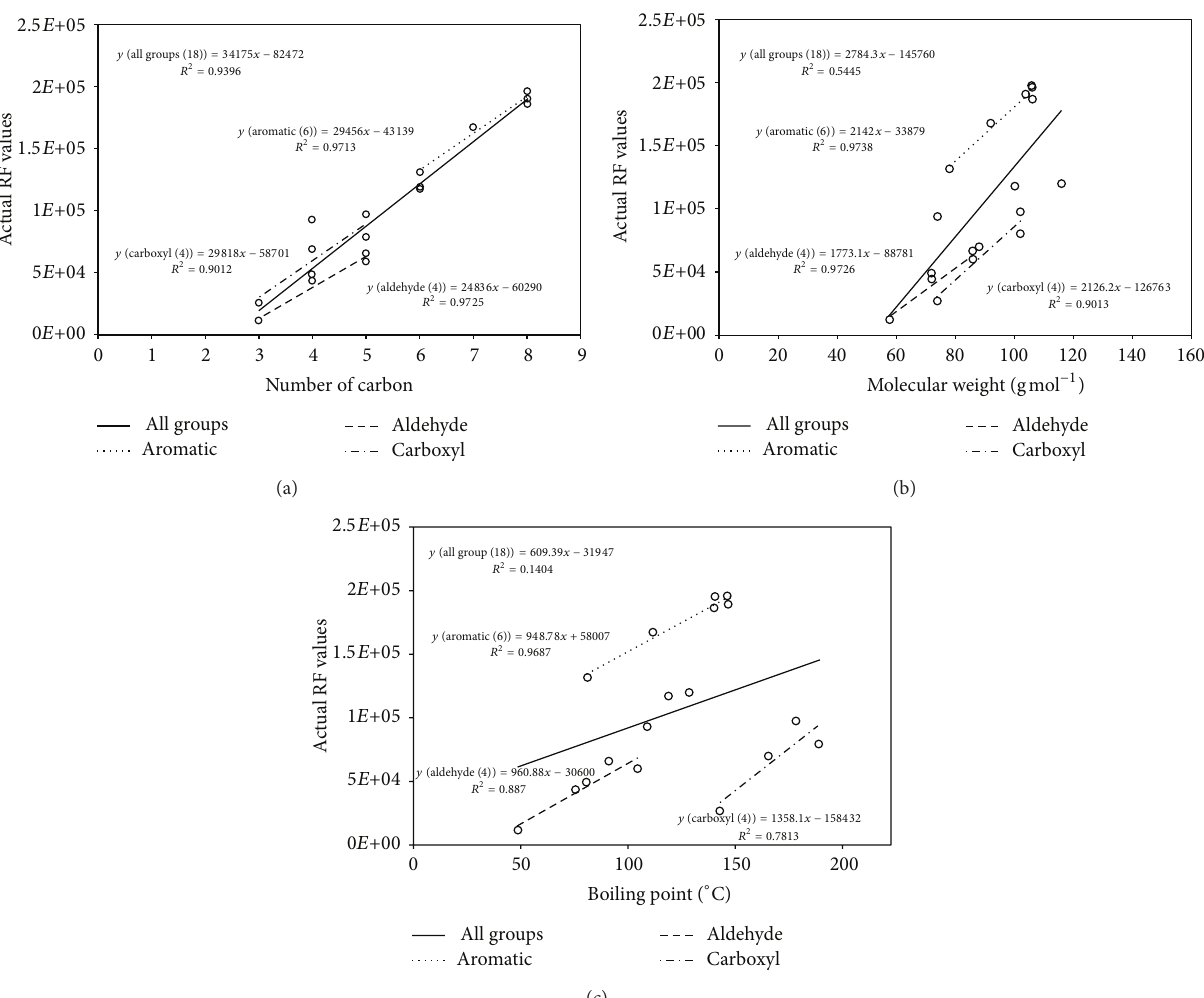
equation for any CLASS, once it is identified as the member of a certain functional